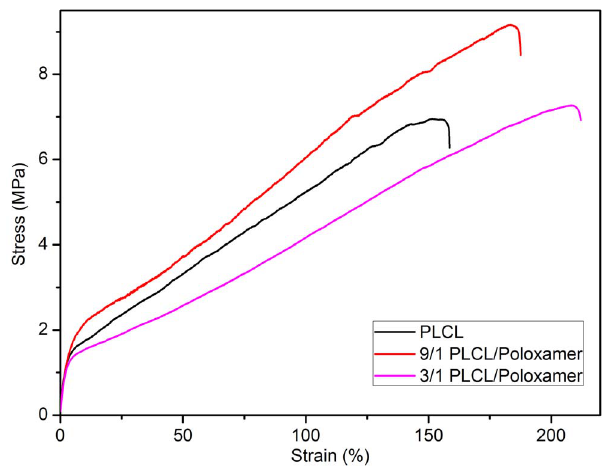
Figure 3. Stress-strain curves for electrospun PLCL/Poloxamer nanofibers with different weight ratio of PLCL to Poloxamer.